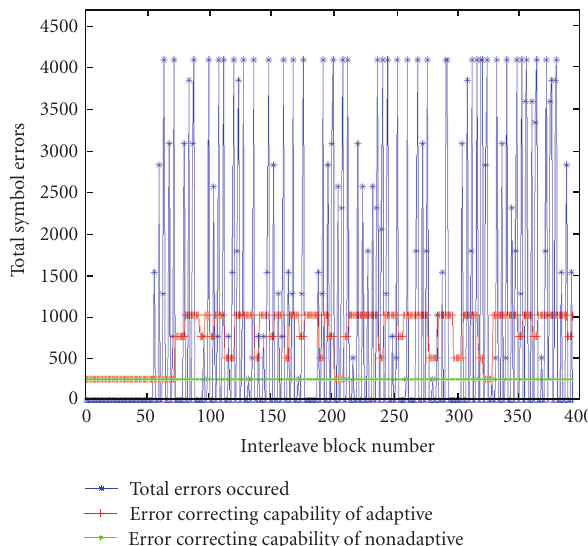
Figure 11: Performance of prediction for “ all ” sequence at 32kbps, random delay 0.028, bu ff er size 175, packet size 256, span 8, PL rate 10.07%.